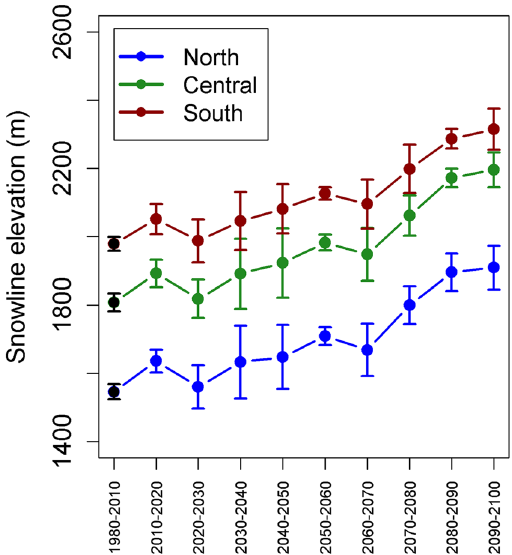
Figure 3. Overall change in snowline elevation. Values plotted are mean snowline elevations (threshold elevation below which monthly T ≥ 0 °C for whole year and consistent snow cover is absent) simulated under baseline climate (1980–2010, black dots) and projected climate (2010–2100, colored dots) for the three transects. Snowline elevations were determined by fitting linear regressions between mean monthly temperature of the coldest month and mean elevation of each climate grid cell (see Supplementary Fig. 6). The corresponding elevation where the regression line crossed the line that temperature equals zero was used as the snowline elevation. Error bars show the standard deviation derived from simulations across general circulation models and replicate